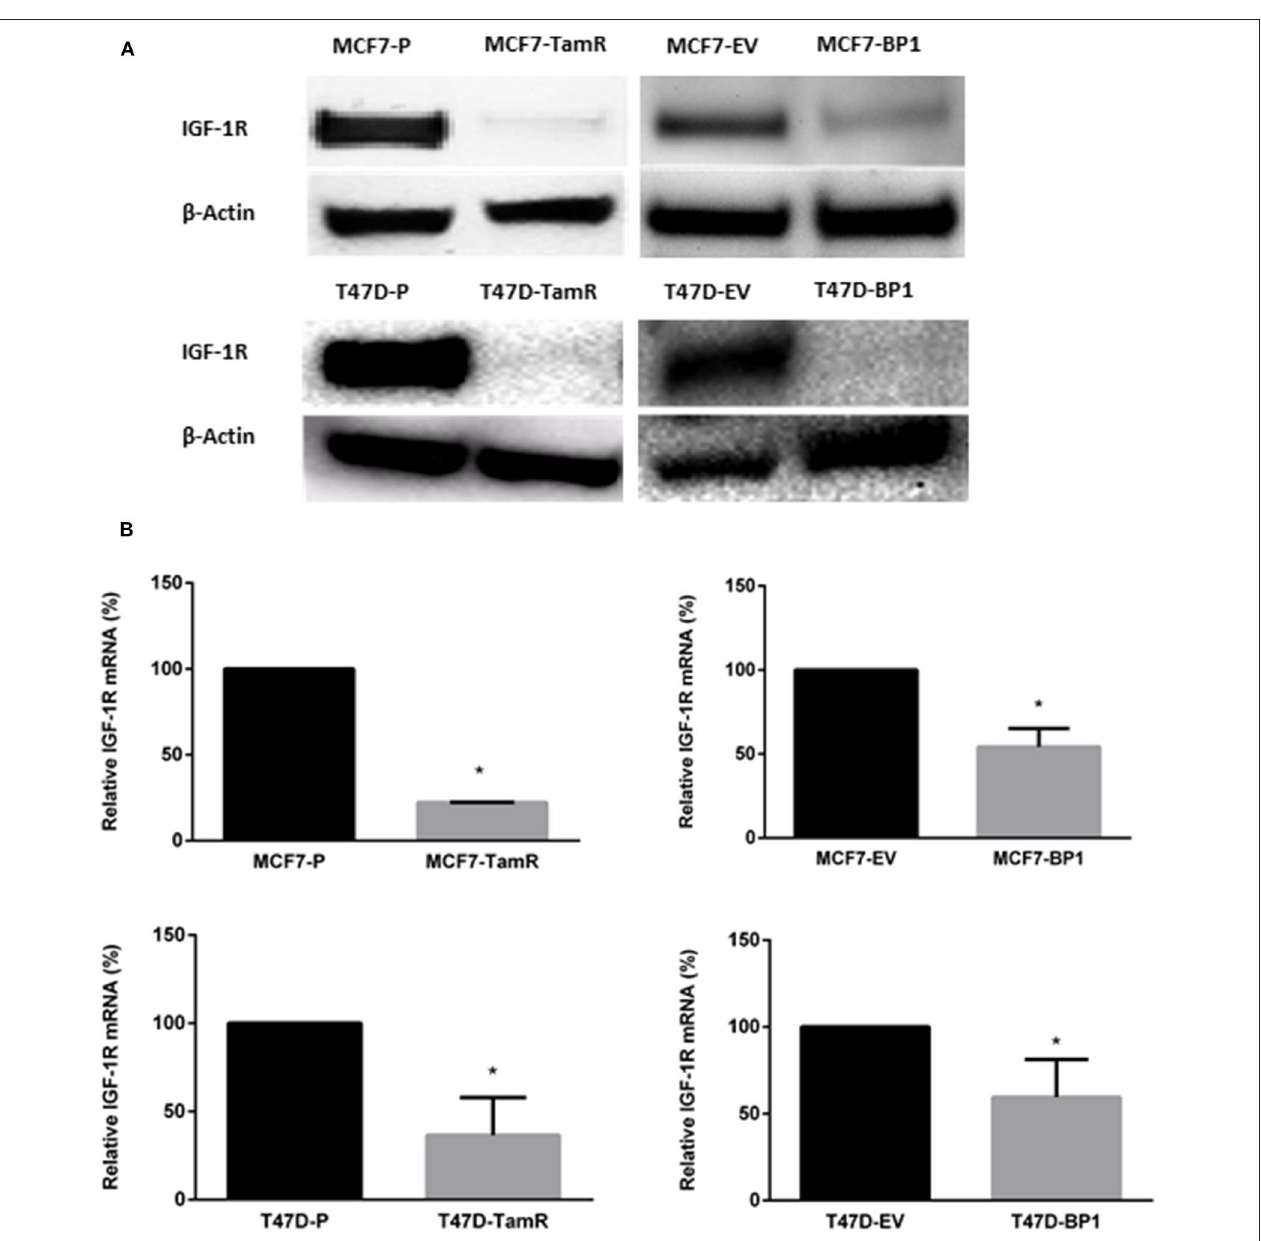
FIGURE 2 | Expression of IGF-1R decreased in MCF7-BP1 and T47-BP1 cells. (A) Immunoblot analysis of IGF-1R protein expressions in MCF-7 and T-47D cells. (B) qRT-PCR analysis of IGF-1R mRNA levels in MCF-7 and T-47D cells. Results are the average of 3 independent experiments, and error bars are the standard error of the mean. * p <